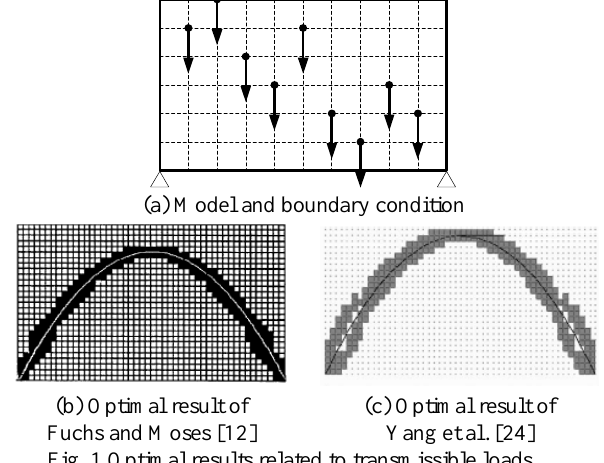
Fig. 1 Optimal results related to transmissible